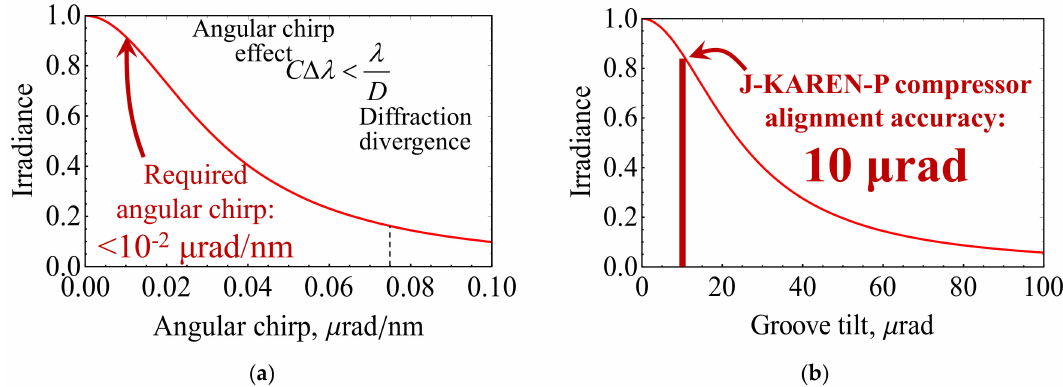
Figure 5. Influence of the angular dispersion and compressor misalignment on the irradiance. These examples are calculated for the J-KAREN-P compressor ( λ = 805 nm, ∆ λ = 38 nm, 284 mm × 256 mm beam, 1480 lines/mm gratings at the incidence angle α = 49.6 ◦ ); the estimates are based on [8]. ( a ) Estimated irradiance vs. amount of angular chirp; the dashed line corresponds to C DL = λ /( ∆ λ · D ) ≈ 0.075 µ rad/nm. ( b ) Estimated irradiance vs. compressor misalignment;